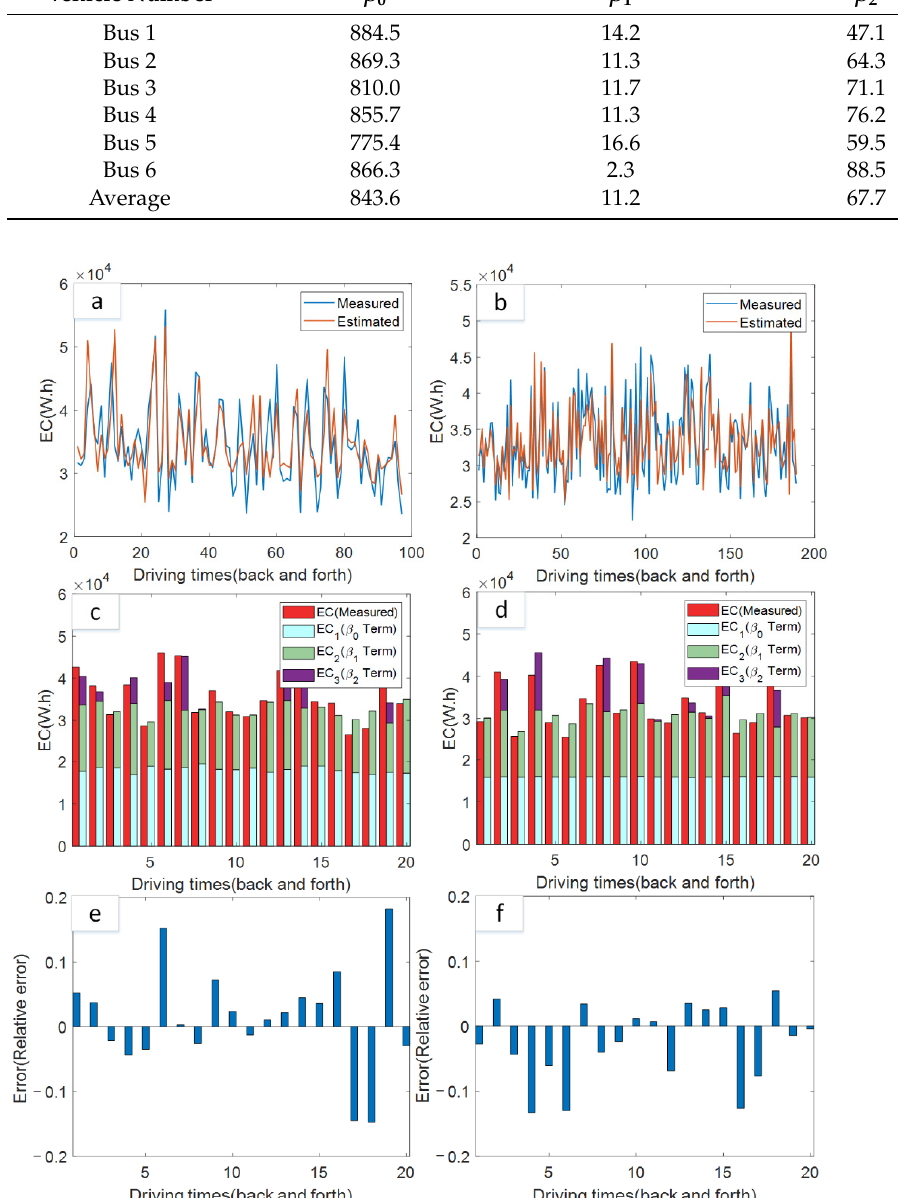
Figure 6. The basic energy consumption estimation results. ( a , b ) The fitting curves of two electric buses. ( c , d ) The energy consumption fitting results for each part. ( e , f ) The fitting errors. It can be seen that the vehicle’s rolling drag energy consumption coefficient is the largest. This shows that the main energy consumption of the vehicle during driving is consumed by the rolling drag. In the figure, Figure 6a,b compare the fitted values of the model with the real values of vehicle energy consumption. In the figure, the x-axis repre- sents the number of vehicle round trips, and the y-axis represents the energy consump- tion. The model-fitting results are close to the values in terms of vehicle energy consump- tion data. Figure 6c,d show the proportion of the energy consumption of each component in the total energy consumption as a histogram. It is obvious that rolling drag and kinetic energy change dominate the energy consumption. Since the use of an air conditioner is closely related to the temperature difference between inside and outside the vehicle, the energy consumption data of the air conditioner fluctuate greatly. The errors of the basic energy consumption model are shown in Figure 6e,f. It can be seen that the average error of the estimation results is 7%. Since the model does not consider the influence of energy consumption fluctuations, there are large errors in the estimation of vehicle energy con- sumption.